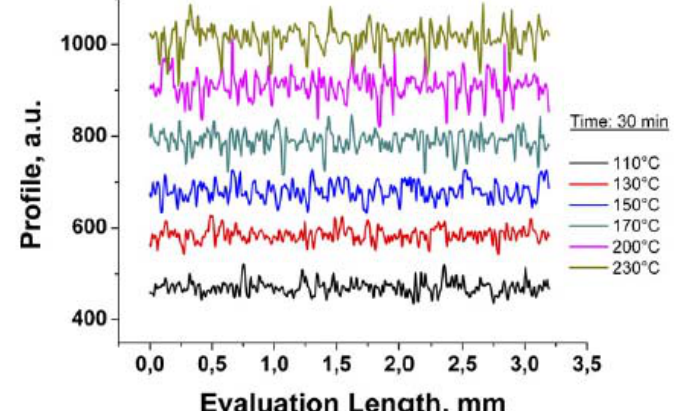
Figure 10: Surface properties after FBM treatment at different temperature (Barletta,